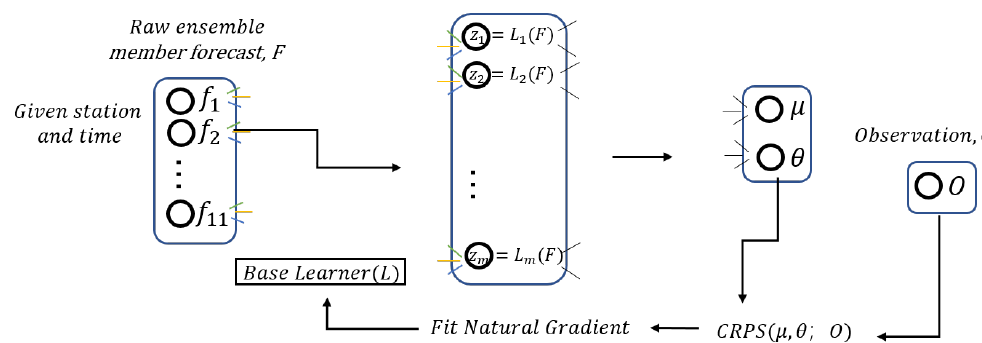
Figure 2. The flowchart of natural gradient boosting (NGBoost). 𝑭 or 𝑓 1 ,𝑓 2 ,…,𝑓 11 , the raw ensemble forecasts and as the inputs; 𝑳 or 𝐿 1 ,𝐿 2 ,…,𝐿 𝑚 , the base learner; 𝜇 and 𝜎 , the two target parameters: mean and standard deviation; 𝑂 , the verification or the observation; CRPS, the continuous ranked probability score. Here, 𝑚 is the number of base learners.